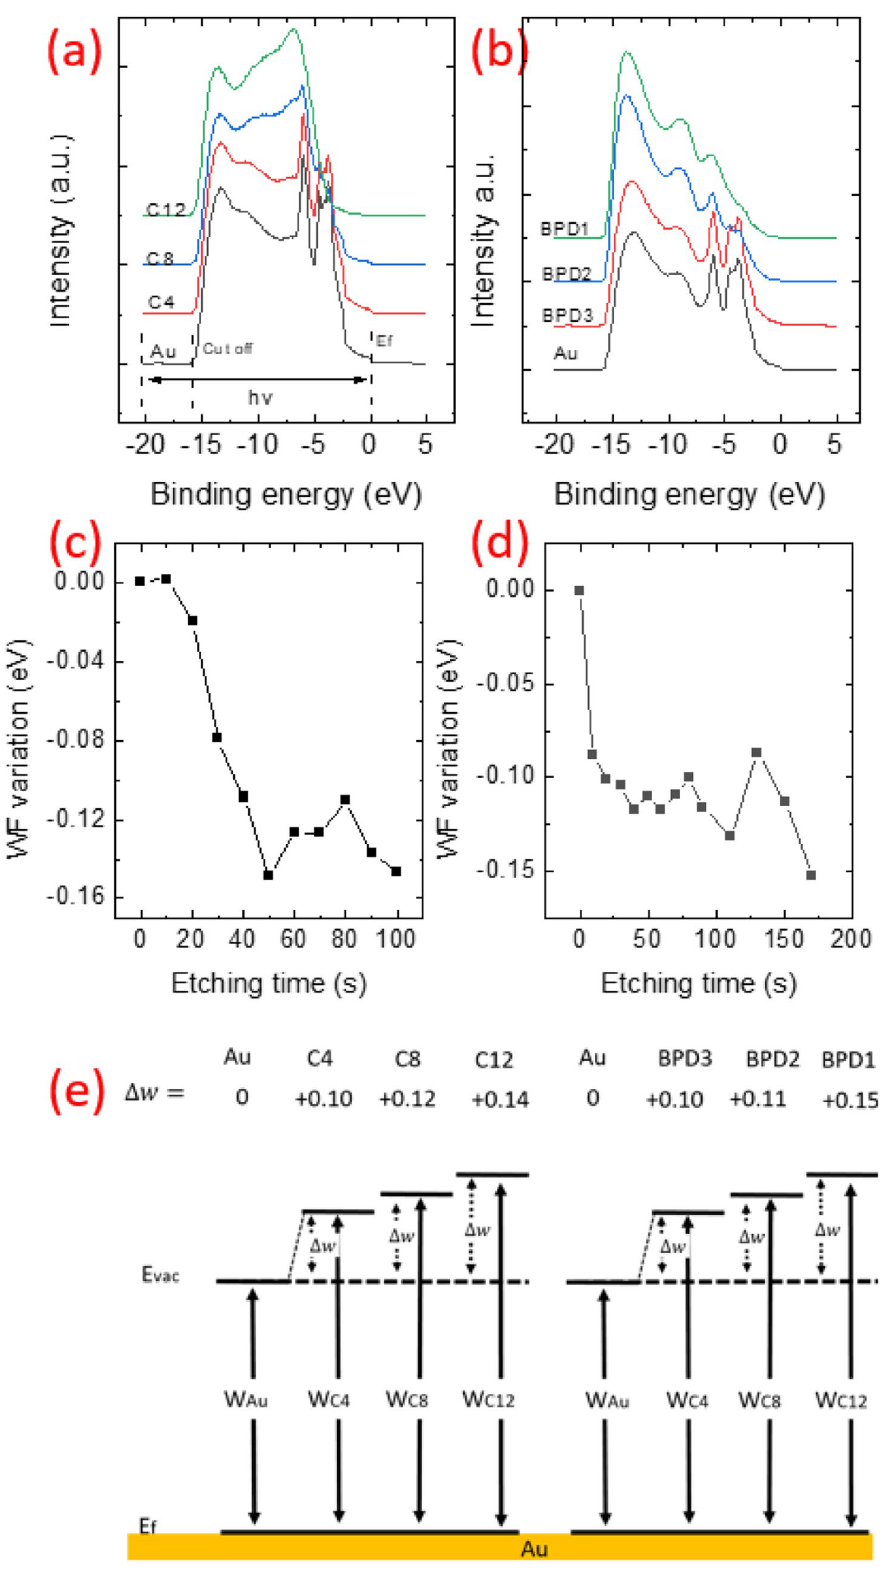
Figure 7. ( a, b ) UPS signals of C12 ( a ) and BPD ( b ) SAMs. (c, d) The Work function (WF) variations of the C12 ( c ) and BPD ( d ) as a function of the etching time. C2, C4 and C8 represent steps at different molecular lengths as described in Fig. 5, the same is for BPD1, BPD2 and BPD3 (with BPD1 the integrated BPD layer at 0 s etching level; BPD2 an intermediated stage of 30 s, BPD3 BPD remaining fragment at final etching level of 160 s). The cut-off and Fermi level were taken from the UPS spectra for work function calculations. ( e ) Schematic representation of work function variations for the considered